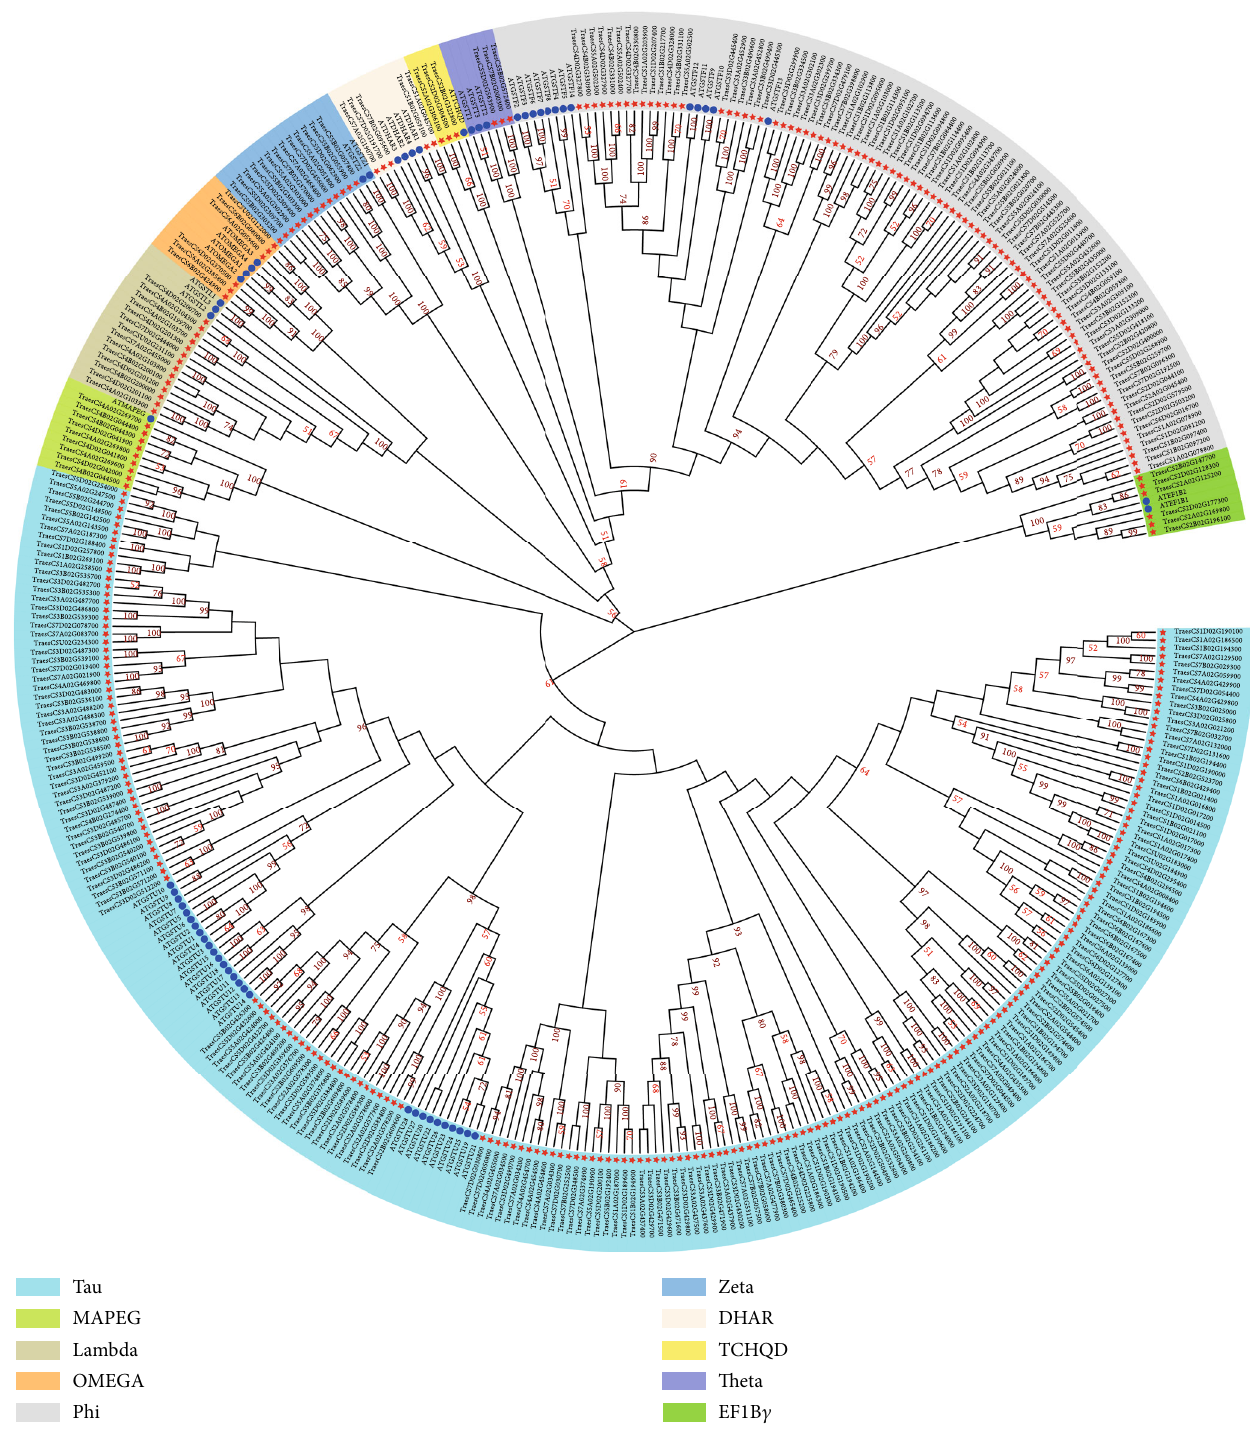
Figure 1: Phylogenetic analysis of glutathione S-transferase genes in T. aestivum and A. thaliana . The phylogenetic tree was constructed using the neighbor joining method by MEGA-X software; bootstrap scores of > 50% are displayed; T. aestivum and A. thaliana genes are represented by a red star and blue circle, respectively. Di ff erent background colors represent di ff erent